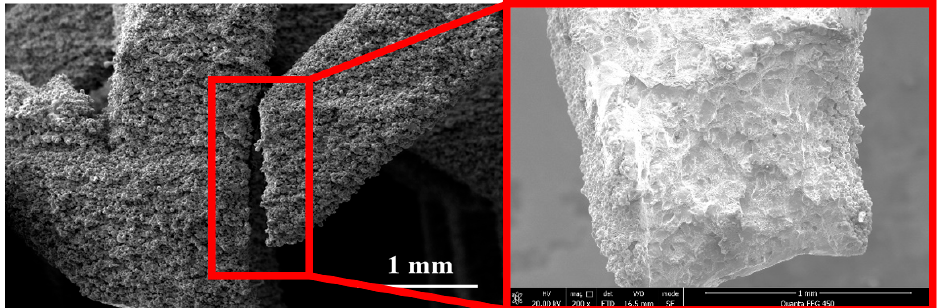
Figure 8. The micro cracks in the oblique strut of the 3D auxetic structure.